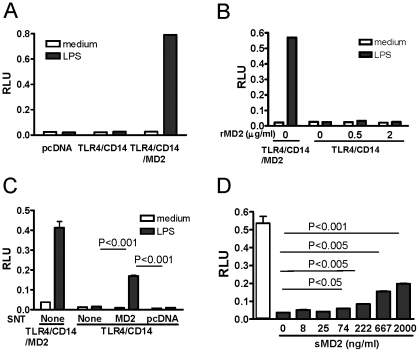
Requirement of MD2 in TLR4 signaling.HEK293T cells were transfected with a mixture of all plasmids as in Figure 1 (TLR4/CD14/MD2), plasmids encoding only TLR4 and CD14 (TLR4/CD14), or control plasmid (pcDNA), stimulated with LPS (1 ng/ml) for 16 h and the lysates were evaluated for luciferase activity (A). TLR4/CD14-transfected HEK293T cells were stimulated with LPS in culture in the presence of increasing amount of recombinant human MD2, and the lysates were evaluated for luciferase activity (B). Culture supernatants (SNT) from MD2- or empty vector- (pcDNA) transfected cells were added to TLR4/CD14-transfected cells prior to LPS stimulation and luciferase activity was determined in cell lysates (C). A specific amount of affinity-purified sMD2 was added in culture media of TLR4/CD14-transfected cells before LPS stimulation (dark bars). TLR4/CD14/MD2-transfected cells with LPS stimulation were included as positive control (open bars) (D). Results shown are representative of data from at least 3 independent experiments, each with similar results.